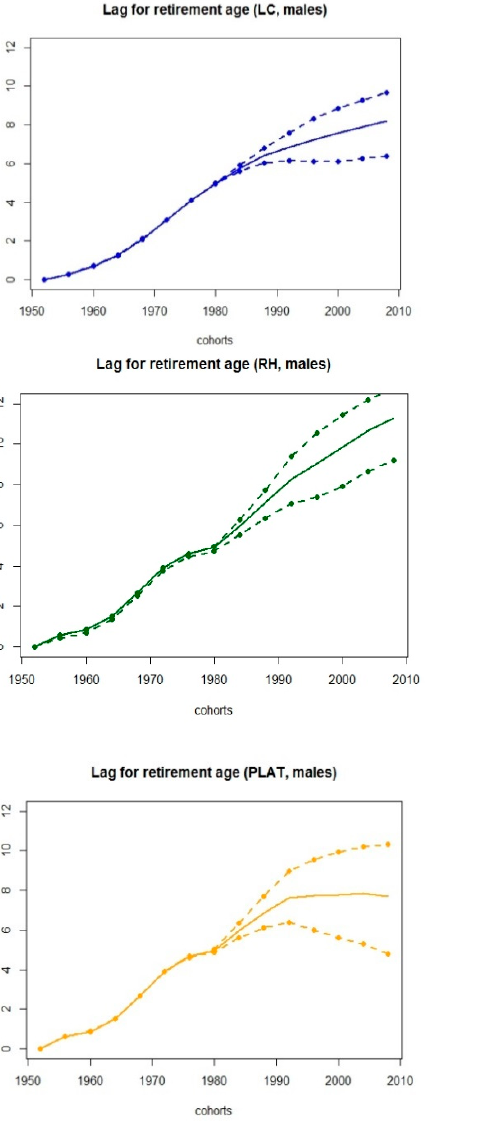
Figure 6. Expected life span at age 65 for each model with corresponding scenarios.